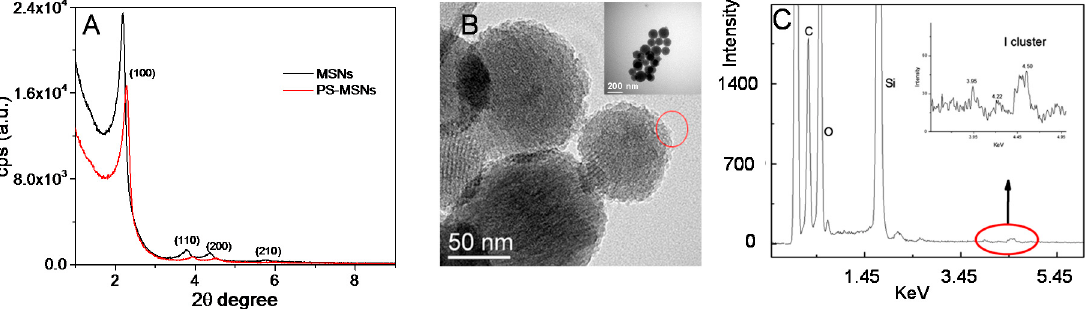
Figure 1. ( A ) X-ray powder diffraction (XRD) patterns of mesoporous silica nanoparticles (MSNs) (black line) and PS-MSNs (red line). ( B ) Representative TEM images and ( C ) EDX analysis of the PS-MSNs. The inset B shows a homogeneous distribution of the nanoparticles and the inset of C shows a zoom in the region of the iodide cluster.